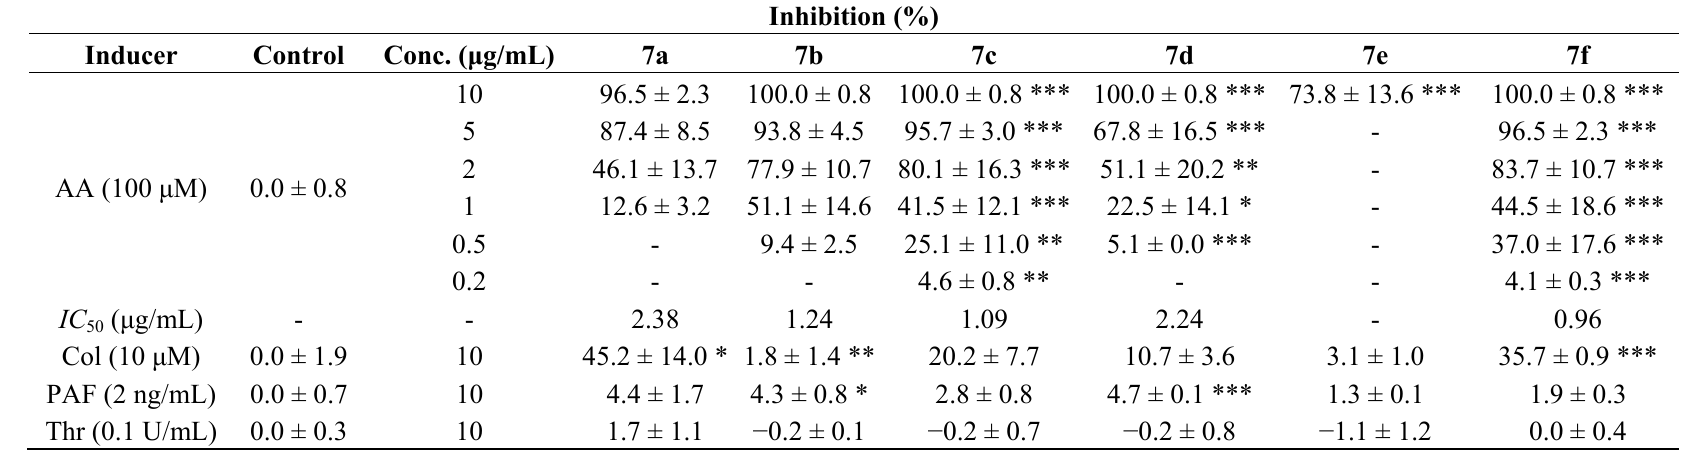
Table 13. Antiplatelet activity of [ n ]-epoxydehydroparadols 7a – f